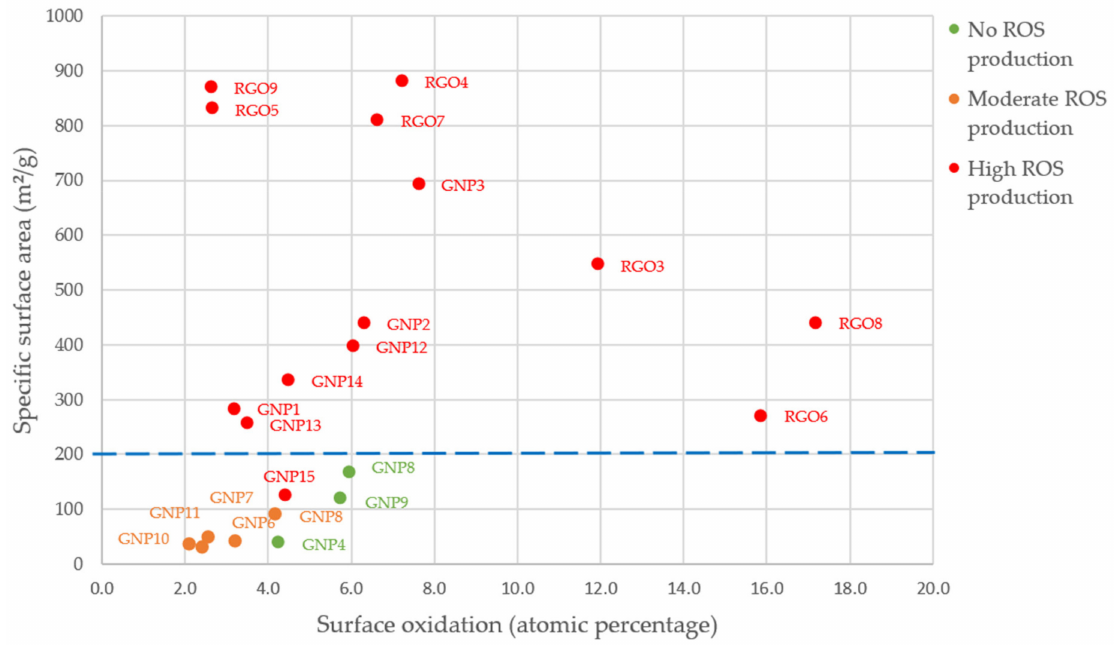
Figure 6. Impact of surface oxidation and specific surface area on ROS production (24-h post-exposure).